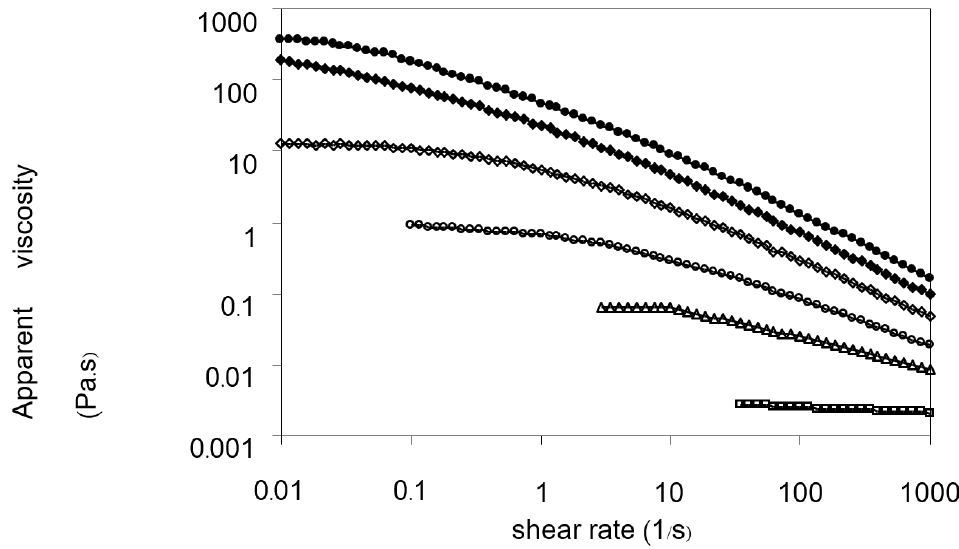
Figure 4. Effect of Yanang gum concentration on the steady-shear viscosity at 25 °C. ( ) 0 . 10%, ( ) 0 . 25%, ( ) 0 . 50%, ( ) 1 . 00%, ( ) 1 . 50%, ( • ) 2 . 00% .